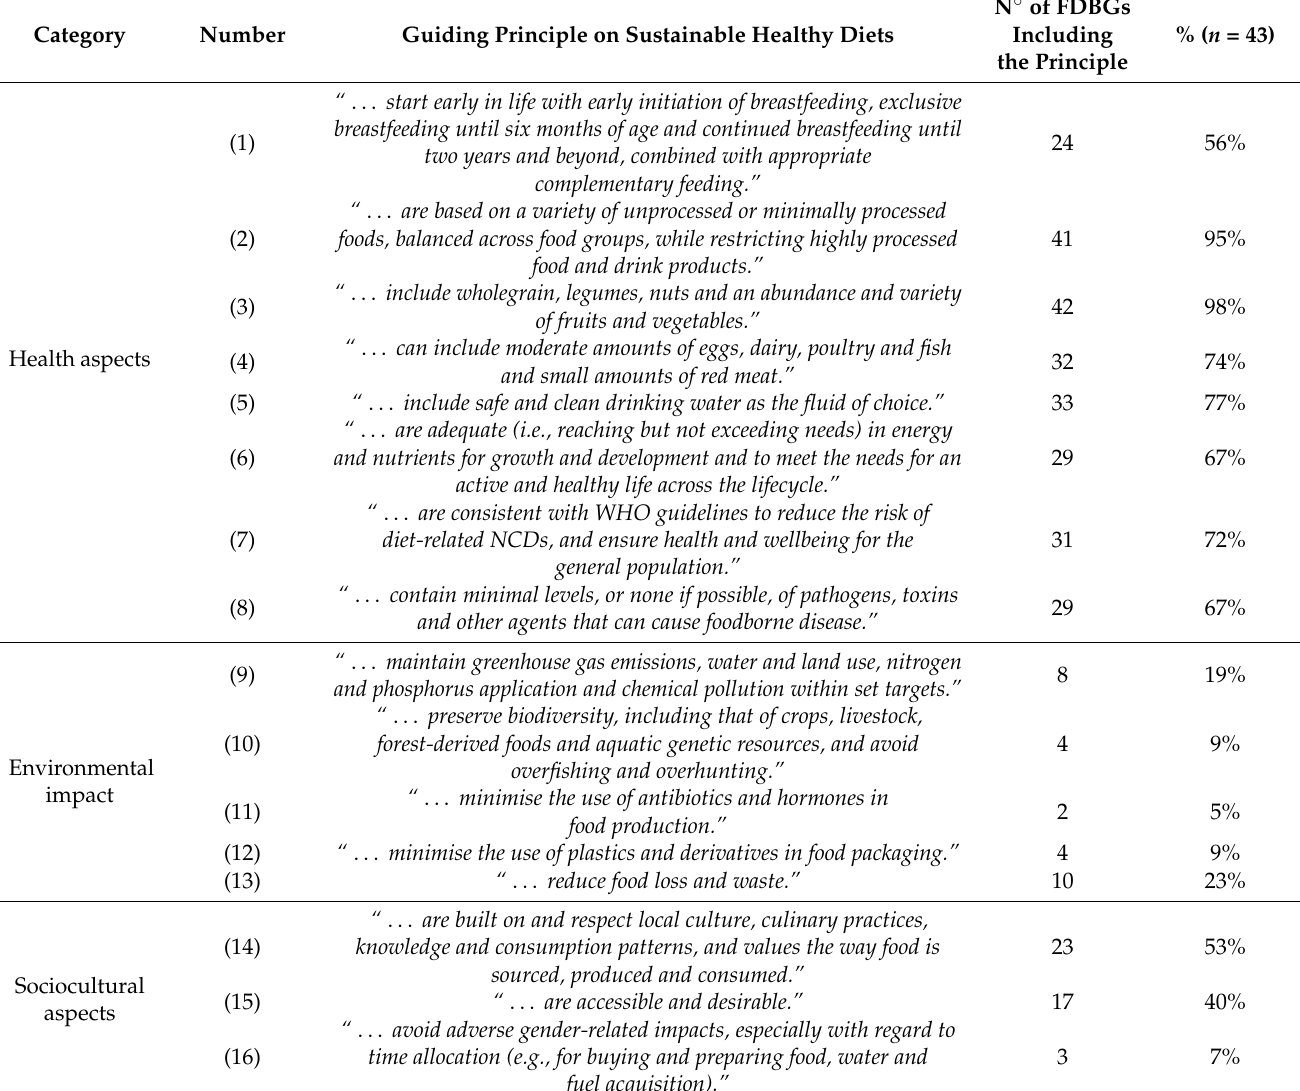
Table 1. Guiding principles for healthy and sustainable diets